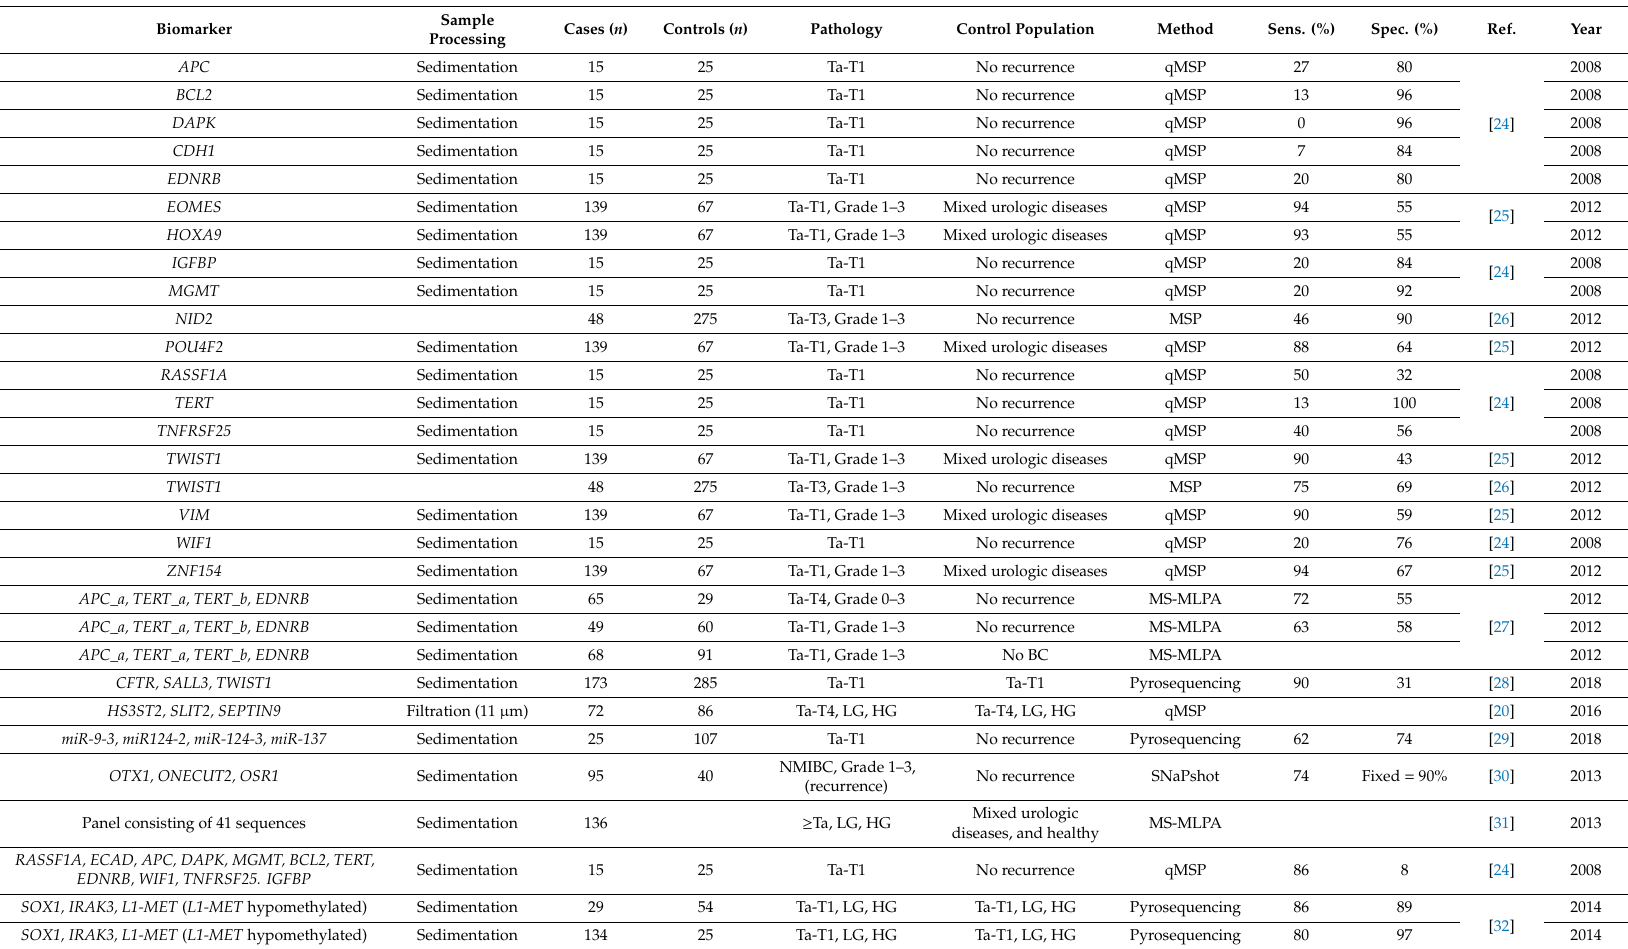
Table 2. DNA-methylation biomarkers and biomarker panels for detection of recurrent bladder